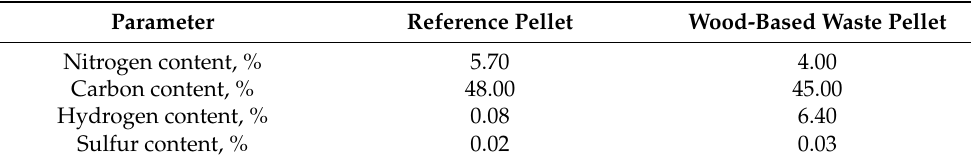
Table 3. Results of elemental analysis of wood-based waste